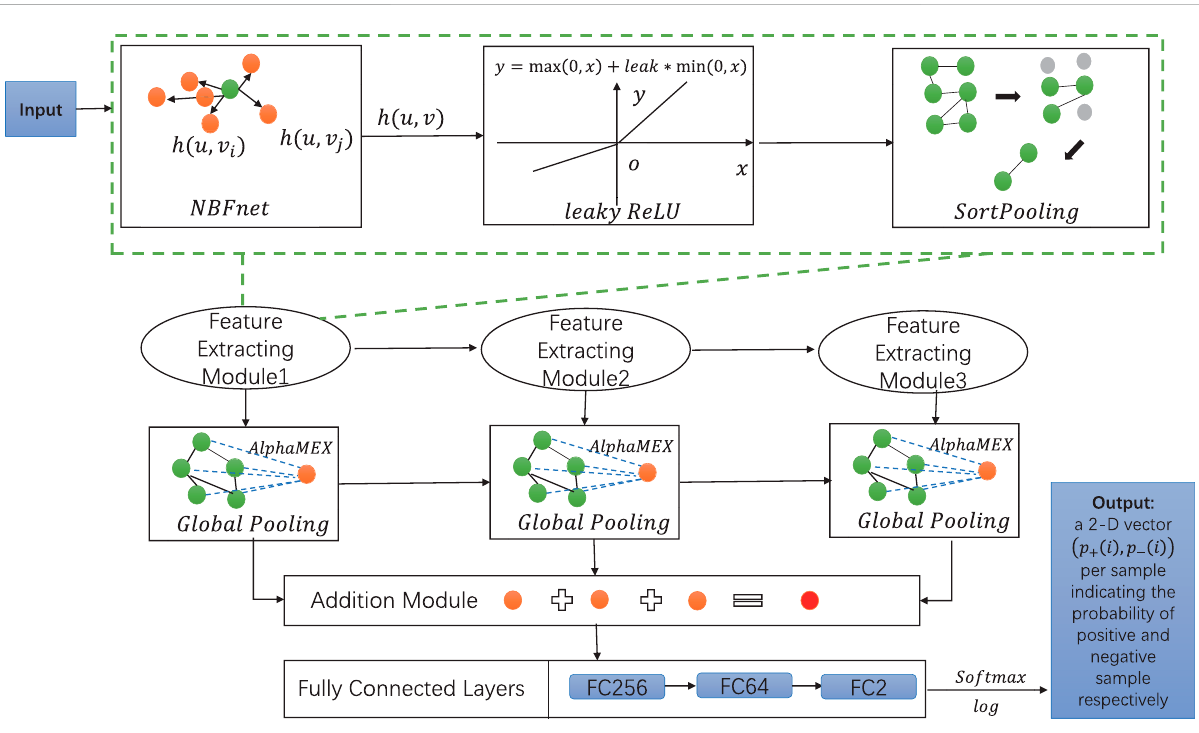
FIGURE 1 The framework of DPB-NBFnet is composed of three feature processing modules, each of whichcontains NBFnet, leaky ReLU (set leak as 0.2), andSortPooling.Consecutively,theframeworkcontainsthreeglobalpoolinglayers,oneadditionmodule,andFClayers(fullyconnectedlayers)with 256,64,2 neurons. A homogeneous graph is fi rst input to the feature extracting module. The output is then processed by the following two feature extractingmodules.TheoutputofthreefeatureextractingmodulesisthenreadbythreeAlphaMEXglobalpoolinglayers,whoseoutputsareput together by the addition module. The outcome of the addition module is then read by three FC layers with 256, 64, and 2 neurons, respectively. We then use a softmax function then a logarithmic function to give the fi nal predicted value p + ( i ) and p − ( i ) to classify the positive and negative samples,